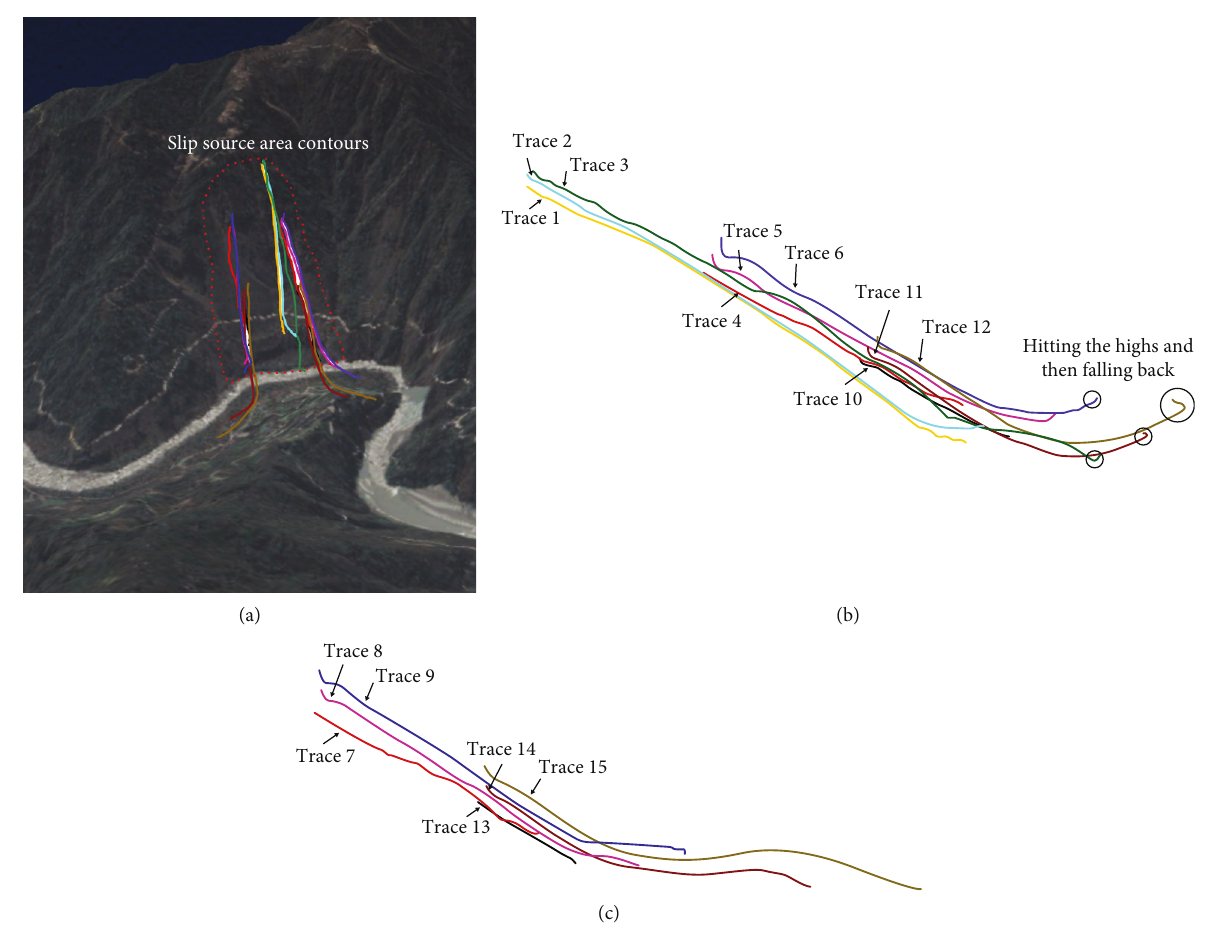
Figure 9: Trajectory monitoring map. (a) Monitoring point trajectory map. (b) A